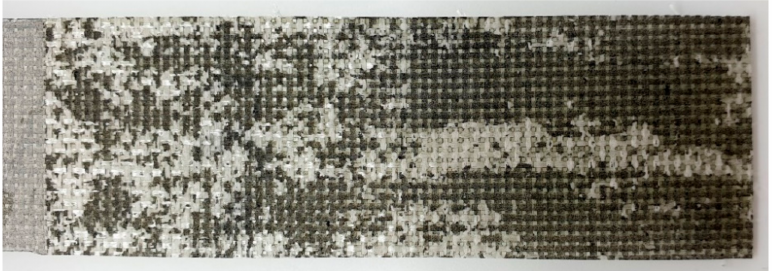
Figure 22. The surface of fractured epoxy-based DCB specimen with MWCNT spray-coated inter- leave after